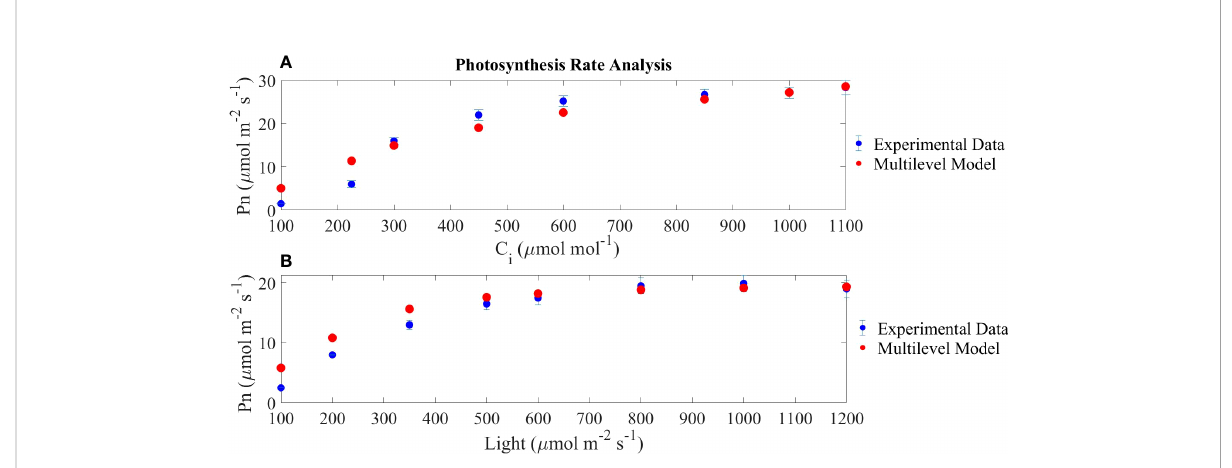
FIGURE 4 Model validation through the comparison of the photosynthesis rate expressed as net carbon assimilation (Pn) as a function of internal carbon concentration and light irradiance. In (A) , a fi xed light intensity of 800 m mol/m 2 /s is set; in (B) , a fi xed internal carbon concentration of 400 m mol/m 2 /s is set. Experimental data are based on Zhou et al. (2020).